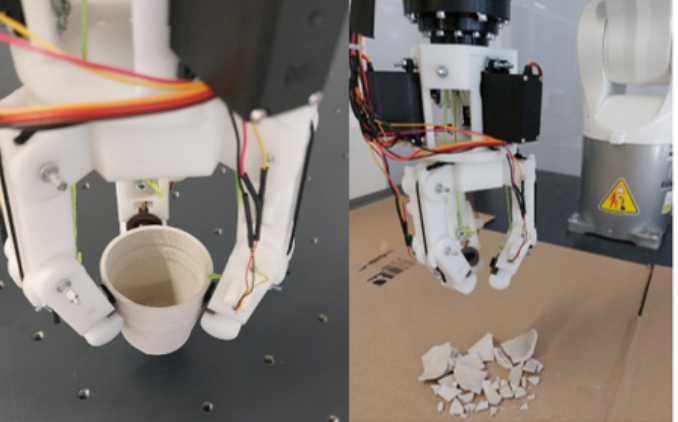
Figure 13. Gripper handling and breaking the raw cup. Source: (Own).